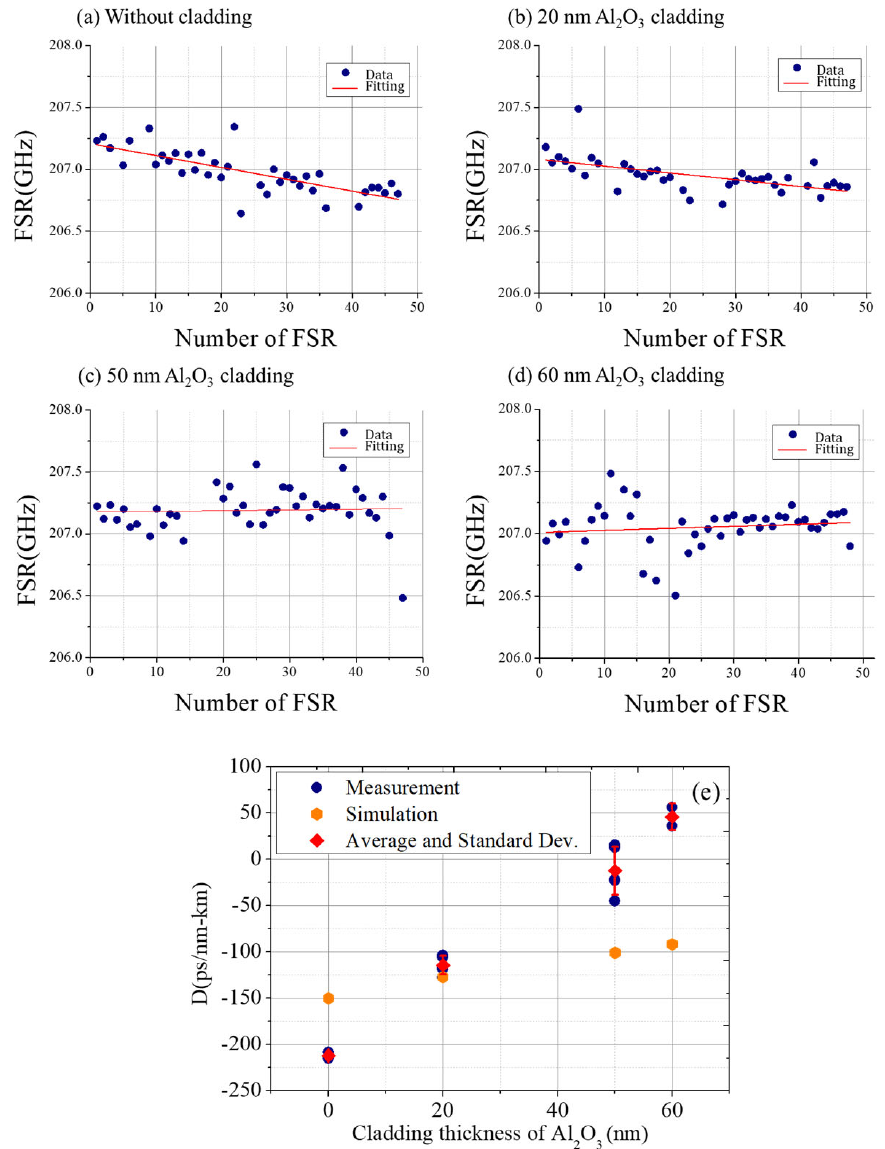
Figure 8. Evolution of FSRs for ( a ) air-cladded, ( b ) 20 nm, ( c ) 50 nm, and ( d ) 60 nm Al 2 O 3 cladded devices. ( e ) The measured waveguide dispersion versus the cladding thickness of Al 2 O 3 cladding.